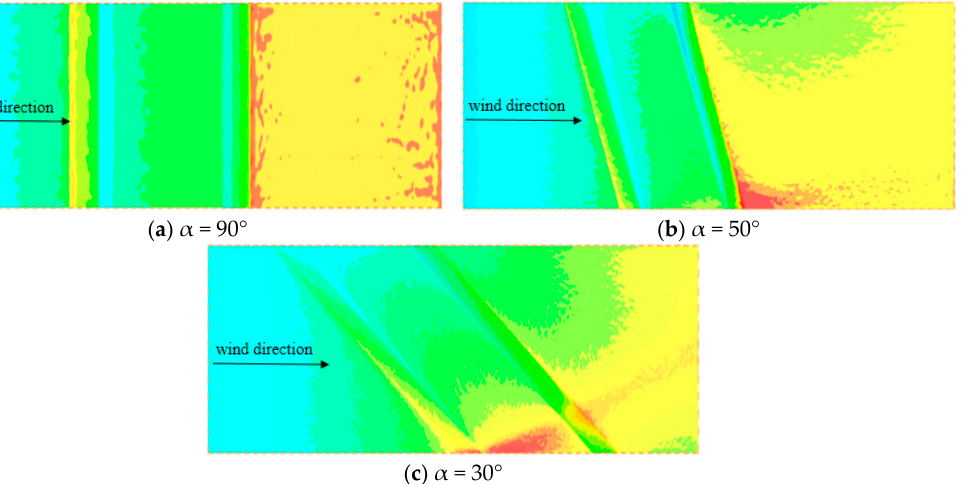
Figure 6. Sand accumulation around embankment under different the wind direction conditions.